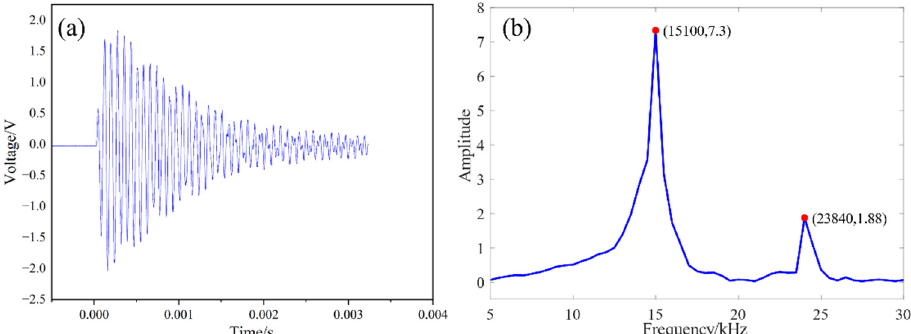
Figure 7. Free attenuation signal and spectrum analysis of high power piezoelectric transducer: ( a ) Free vibration signal of transducer; ( b ) FFT diagram of vibration signal. ( a ) Free vibration signal of transducer; ( b ) FFT diagram of vibration